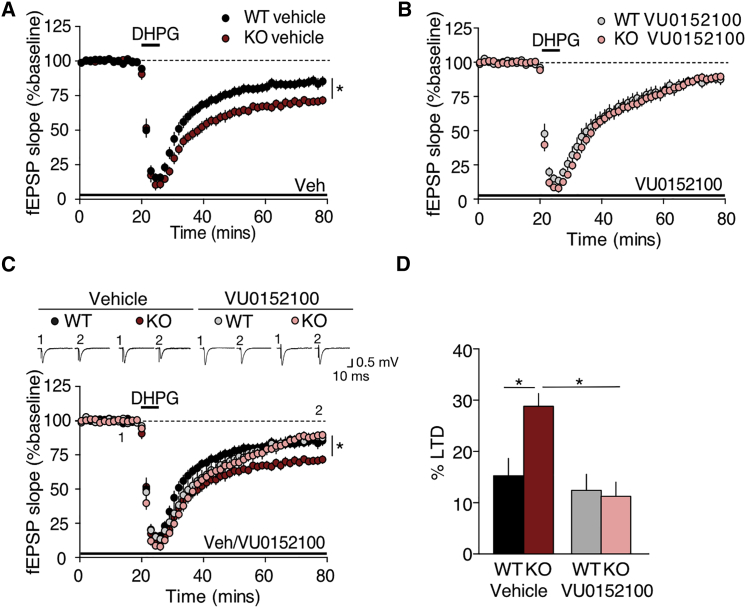
M4 PAM Corrects Exaggerated mGluR-LTD in the Fmr1−/y Mouse(A) Measurement of mGluR-LTD in hippocampal CA1 shows a significant elevation in vehicle-treated Fmr1−/y versus WT (WT = 84.7% ± 3.4%, n = 16, KO = 71.2% ± 2.47%, n = 15, ∗p = 0.0028).(B) Exaggerated LTD in the Fmr1−/y is significantly normalized with 5 μM VU0152100 (KO PAM = 88.7% ± 2.76%, n = 13, ∗p = 0.0003). VU0152100 treatment has no effect on WT LTD (WT PAM 87.6% ± 3.13%, n = 11, p > 0.999).(C) Comparison of all four groups (re-plotted from A and B).(D) Quantification of the last 10 min of recording shows a significant rescue of the LTD phenotype in the Fmr1−/y with VU0152100 (ANOVA genotype × treatment ∗p = 0.0191). n = number of animals. Error bars indicate SEM.